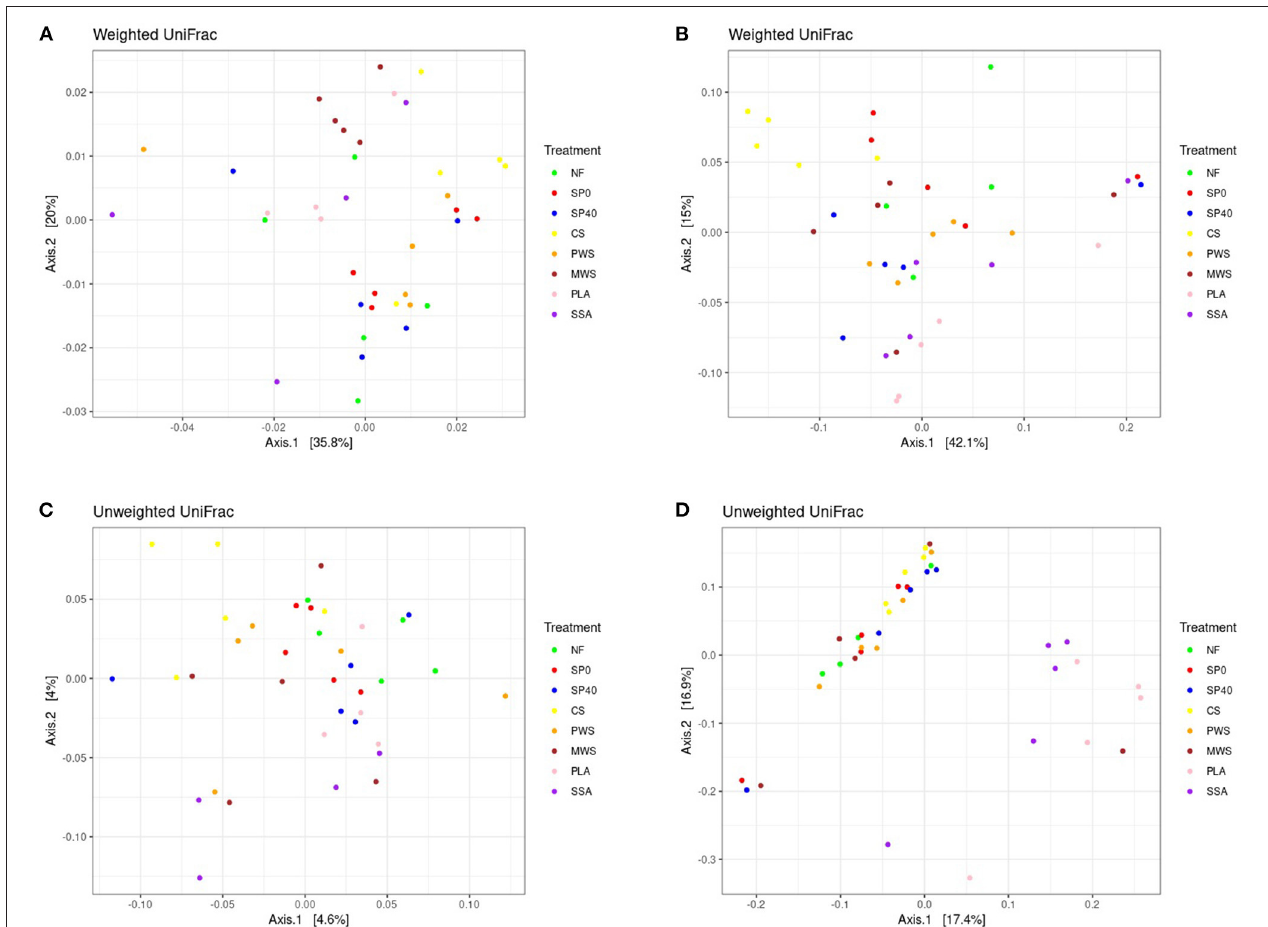
FIGURE 4 | Principal coordinates analysis of (A) bacterial communities and (B) fungal communities based on Weighted Unifrac distances and of (C) bacterial communities and (D) fungal communities based on Unweighted Unifrac distances between samples. Samples are colored by treatment group. NF, No fertilizer; SP0, No phosphate; SP40, mineral super phosphate; CS, cattle slurry; PWS, potato waste struvite; MWS, municipal waste struvite; PLA, poultry litter ash; SSA, sewage sludge ash.